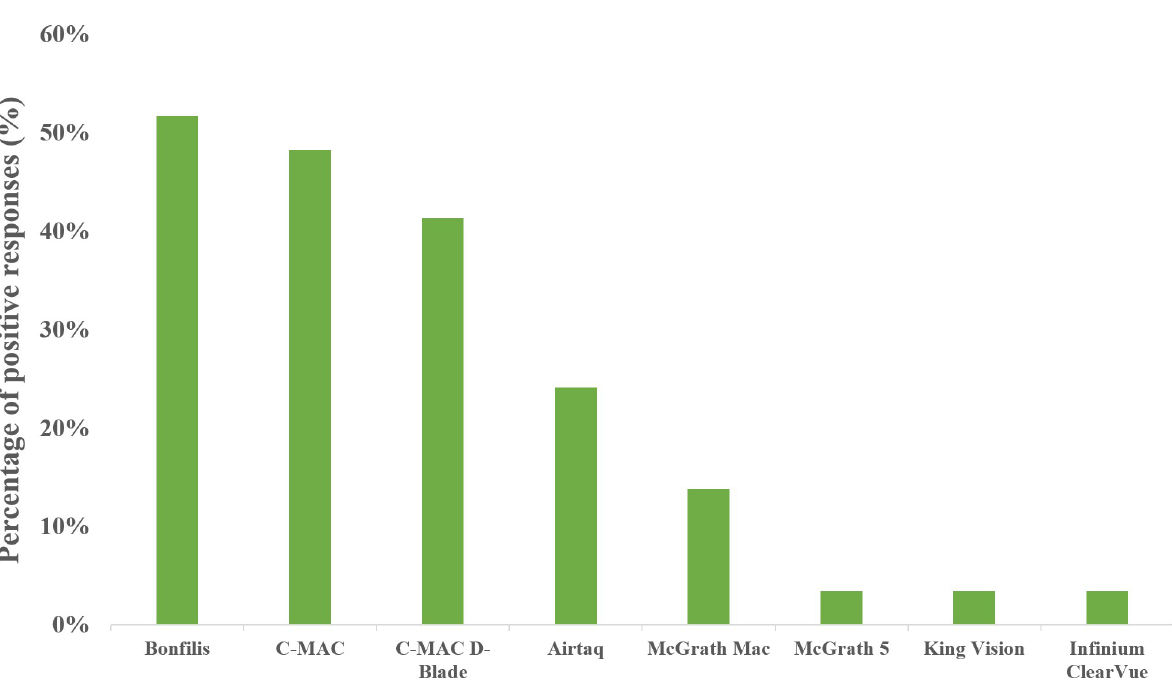
Fig 4. The available devices in Croatia. The eight available VL in Croatia according to this survey (n = 29) and based on positive answers given to the following question: “Which of the following devices are available at your workplace? (Option for multiple answers!)”.